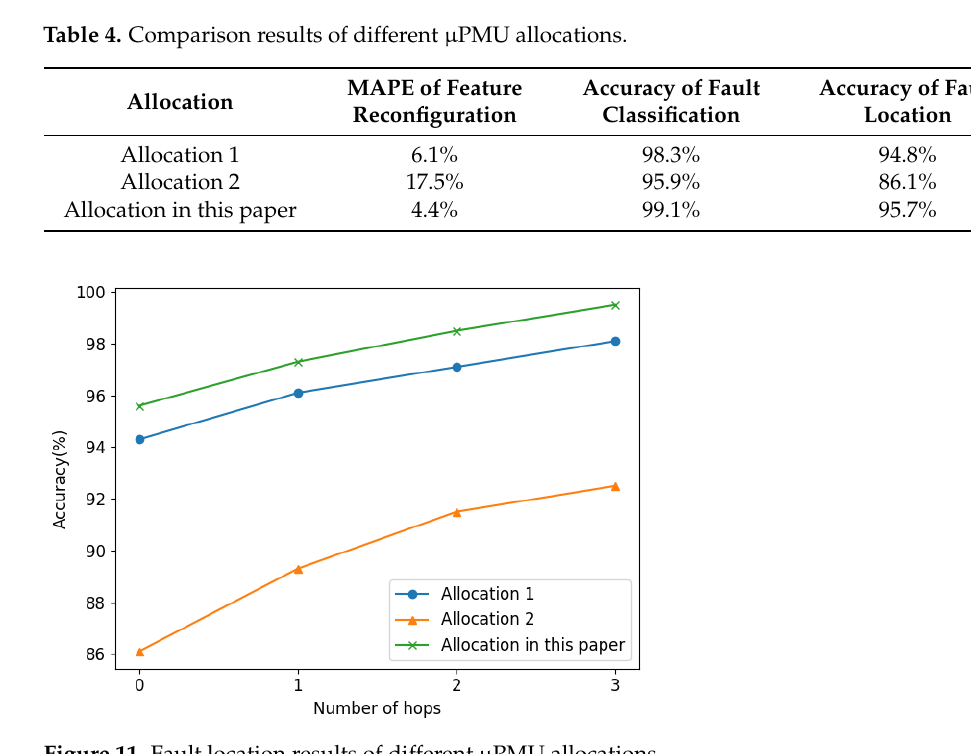
Figure 11. Fault location results of different μ PMU allocations.